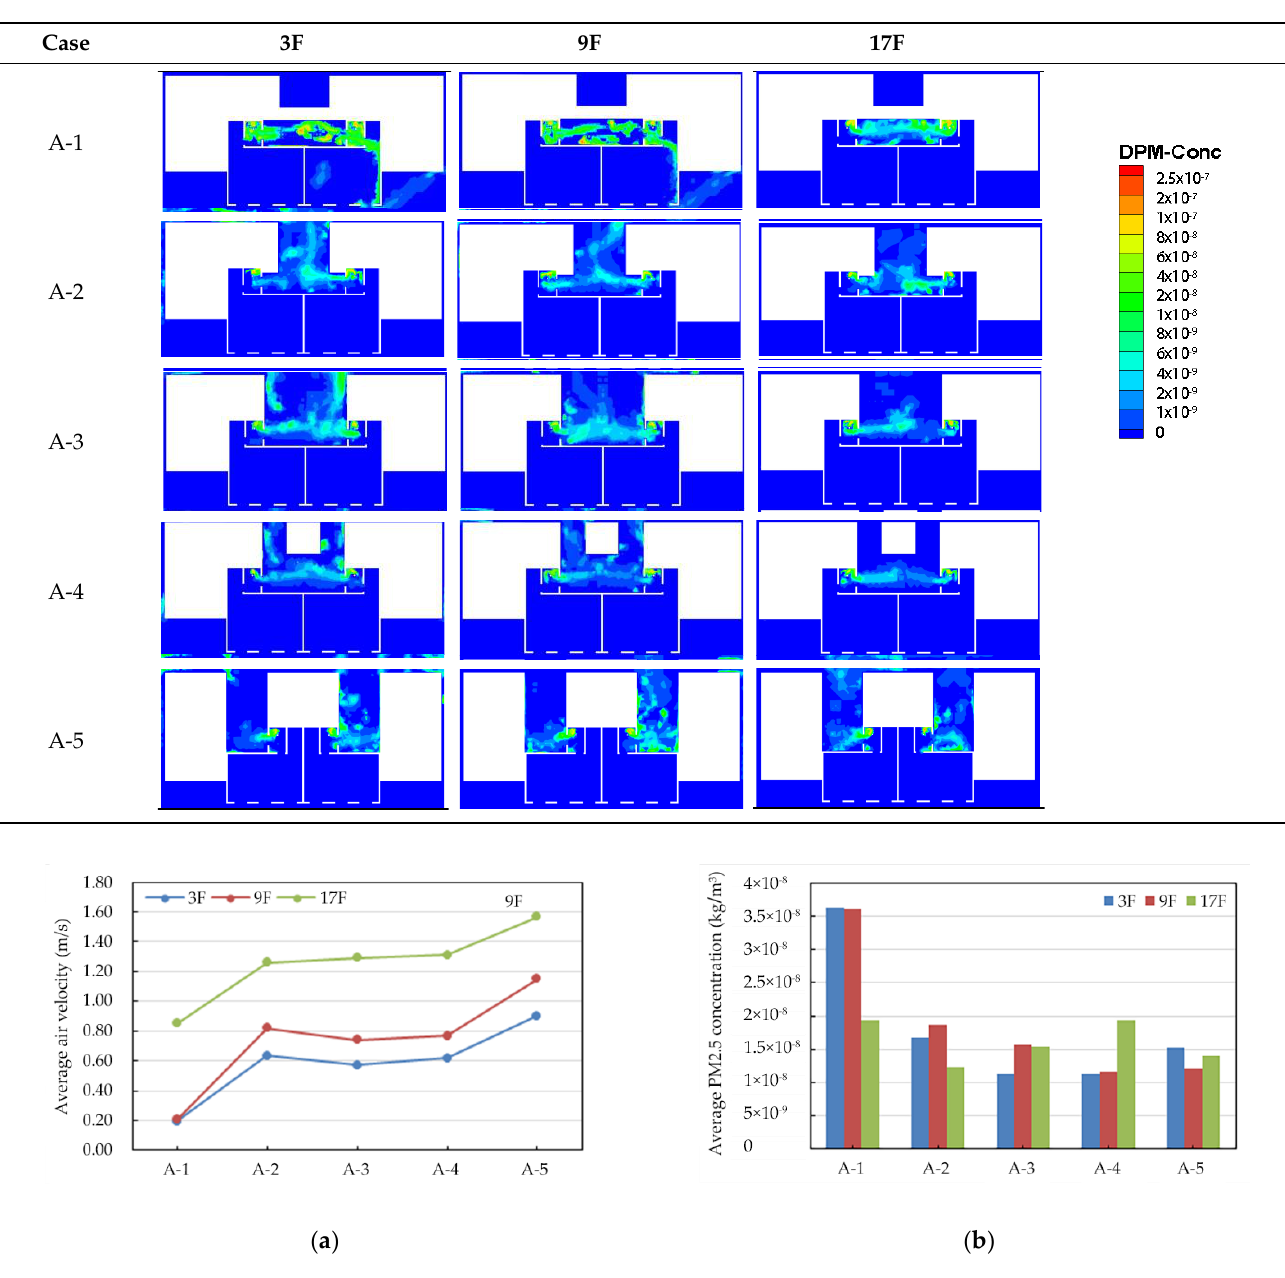
Figure 8. Analysis in kitchens for different inner-courtyard forms: ( a ) average air velocity; ( b ) average PM2.5 concentration. Table 8. Air velocity simulation results for five inner-courtyard variables.